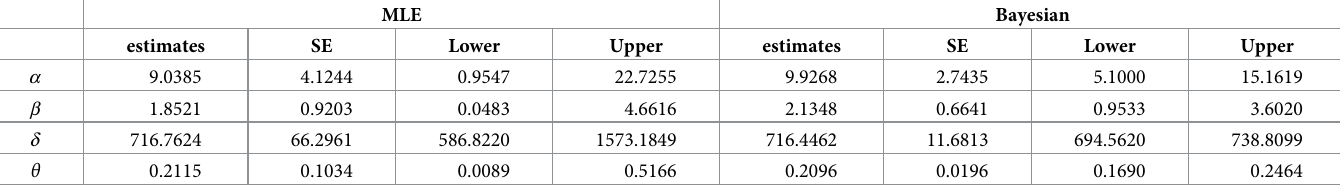
Table 6. MLE, and Bayesian estimates, SE of OLINH distribution for COVID-19 vaccination. MLE estimates